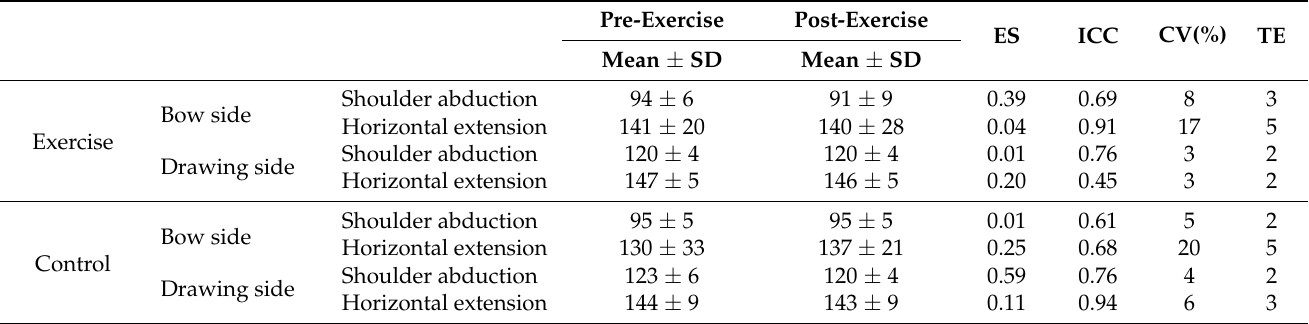
Figure 2. ( A ). Lower trapezius muscle strength of bow side; ( B ). Horizontal abductor of bow side. * p ≤ 0.05 between pre- and post-exercise. Table 1. Shoulder angle